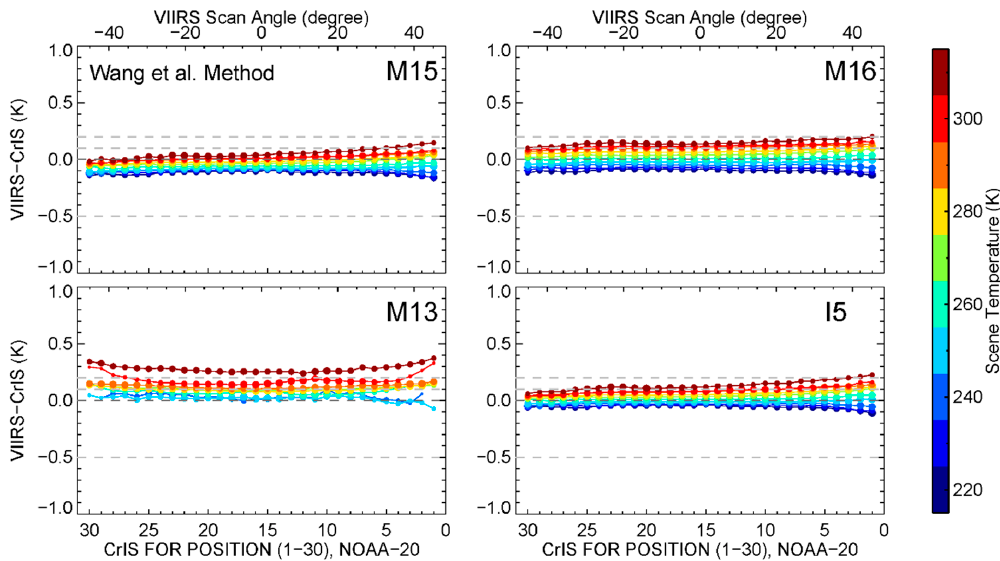
Figure 11. NOAA-20 VIIRS–CrIS BT differences at 10 scene temperatures and as function of CrIS FOR position and VIIRS scan angle. VIIRS M15–M16, M13, and I5 SDRs from March 18, 2019 were reprocessed using the Wang et al. method derived on-orbit RVS. Under each scene temperature, the sizes of the filled circles are proportional to the number of data samples used. Table 5. NOAA-20 VIIRS–CrIS scan averaged biases at 10 scene temperatures for the NOAA operational (prelaunch RVS) and the reprocessed SDRs (the Wang et al. method derived on-orbit RVS). Unit for scene temperatures and biases: K. Prelaunch RVS Wang et al. On-Orbit RVS Scene Temperature